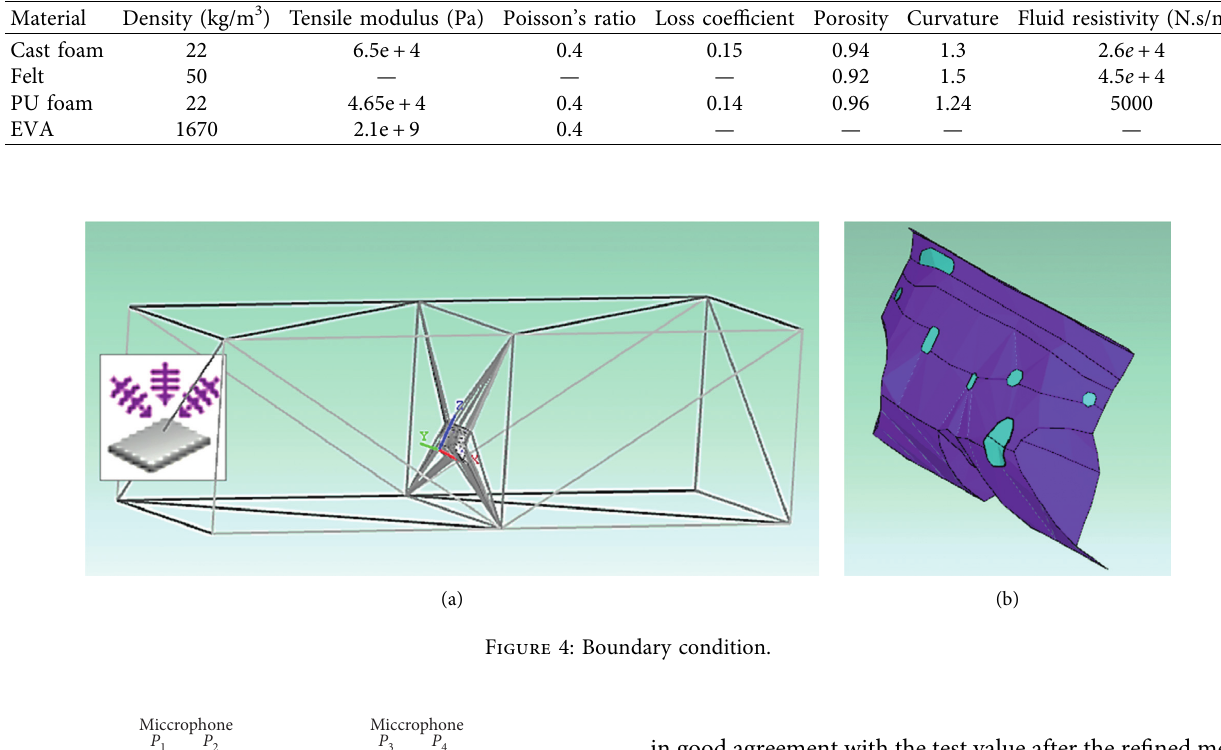
Table 3: Acoustic cover material parameters.